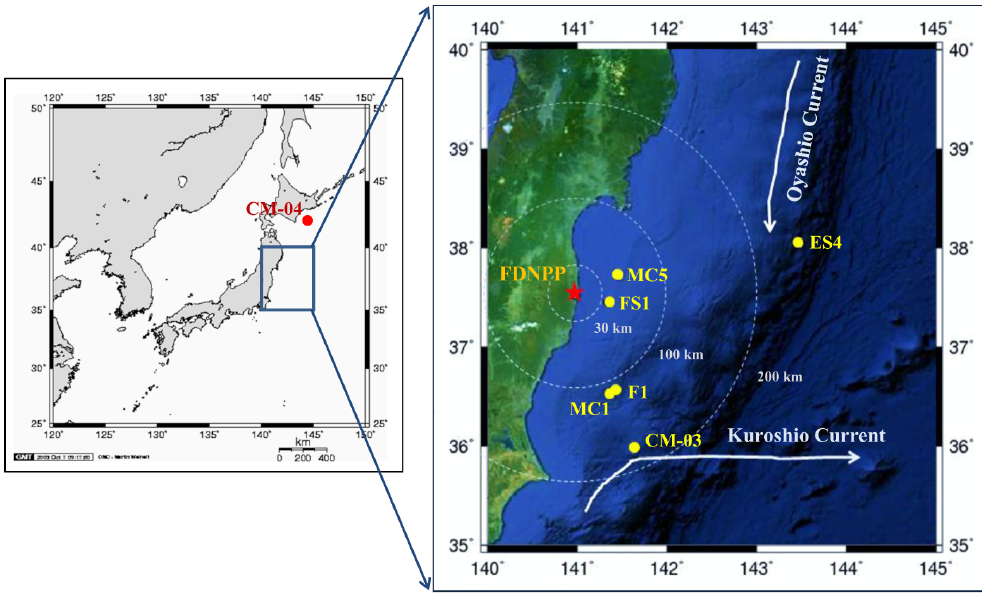
Fig. 2. Map showing the locations of the sediment sampling sites in the western North Pacific and the Kuroshio and Oyashio Currents. Stations CM-04 and CM-03 are from Zheng and Yamada